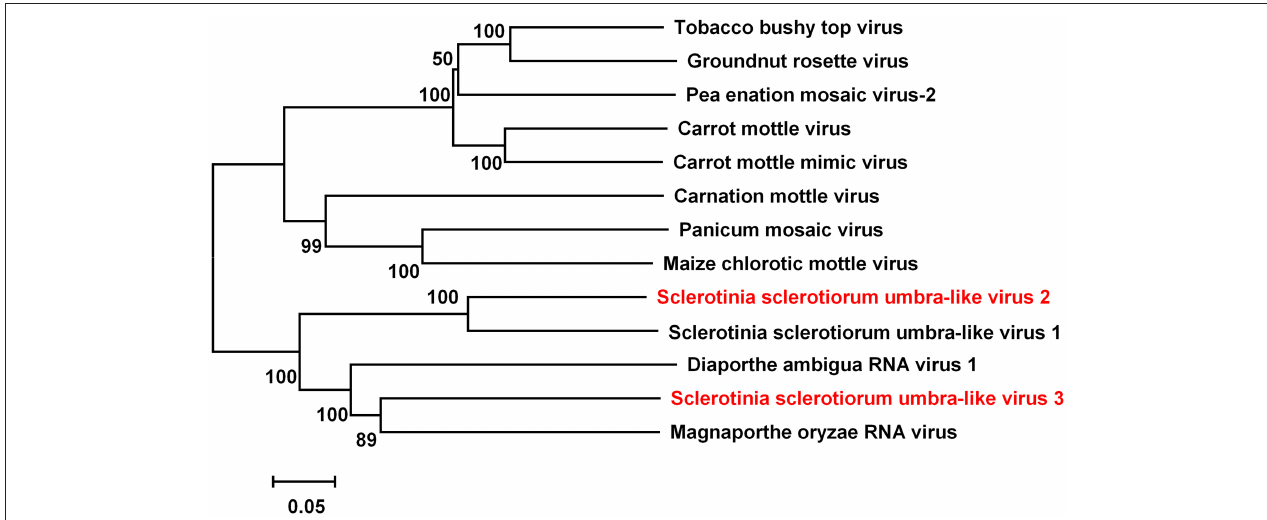
FIGURE 7 | Phylogenetic analysis of virus in the Family Tombusviridae . Phylogenetic relationships of putative new virus genomes of Tombusviridae virus. Viruses marked with red color are found in Australian isolates of Sclerotinia sclerotiorum .